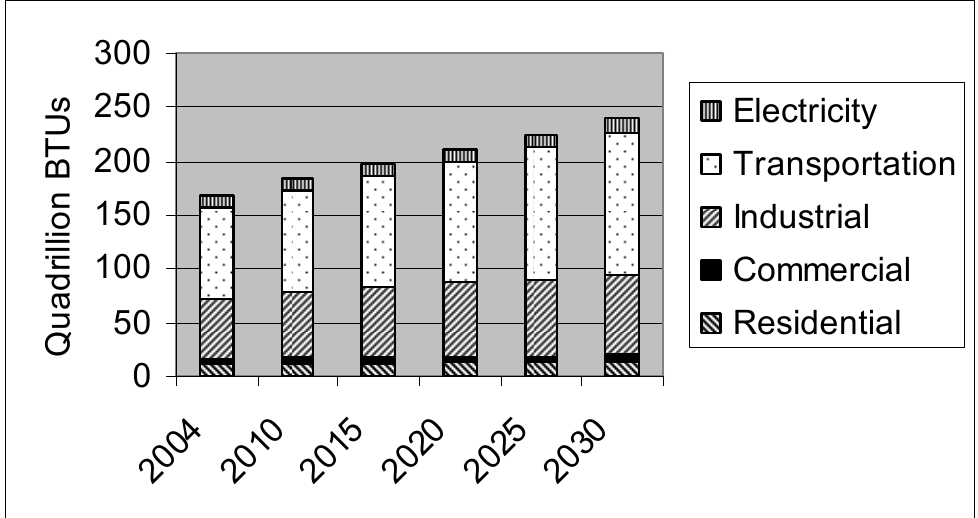
Figure 1. World Liquid Fuel Consumption by Sector